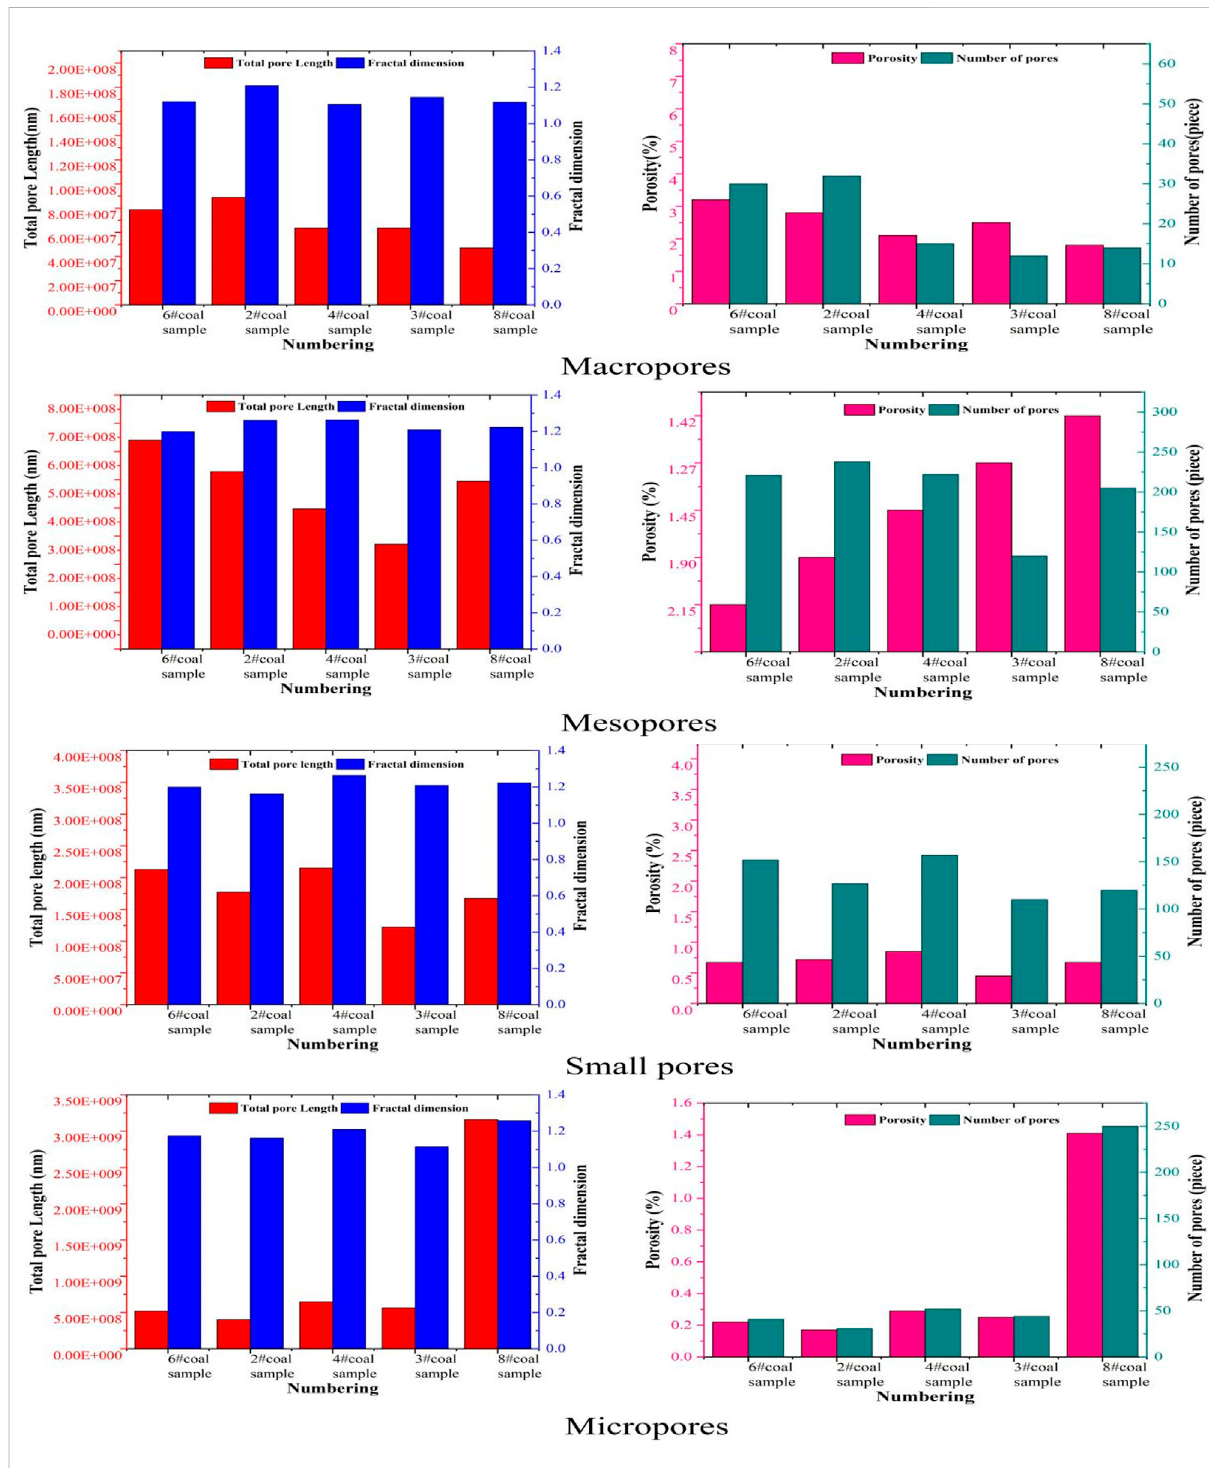
FIGURE 8 PCAS analysis of each coal